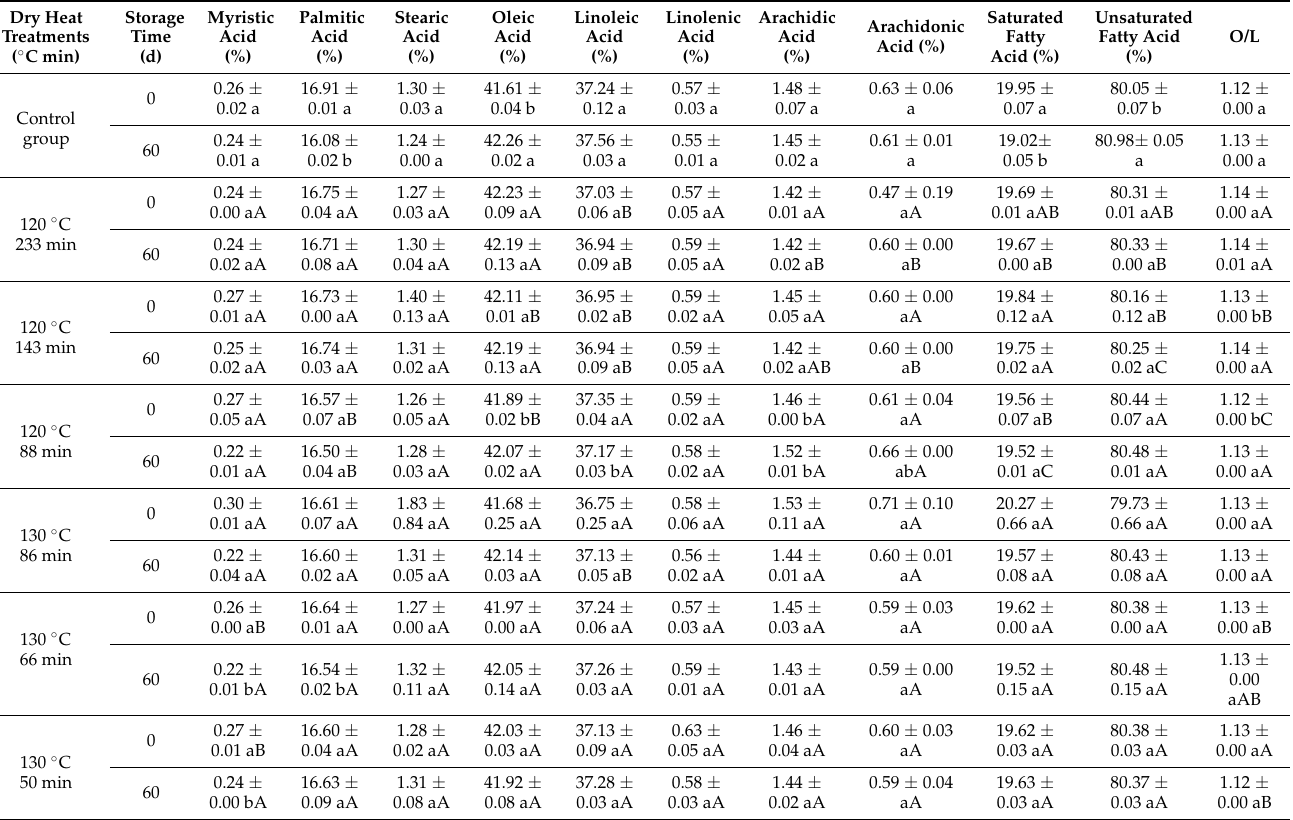
Table 1. Changes in fatty acid composition and content in dry-heat-treated rice